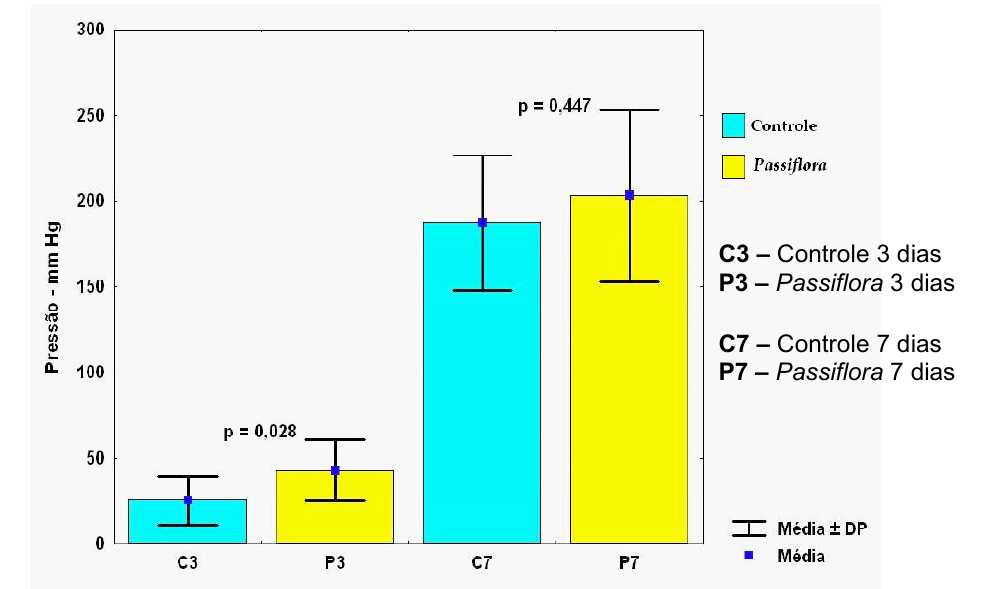
FIGURA 4 – Médias e desvio padrão da pressão de ruptura dos subgrupos C3, P3 E C7, P7